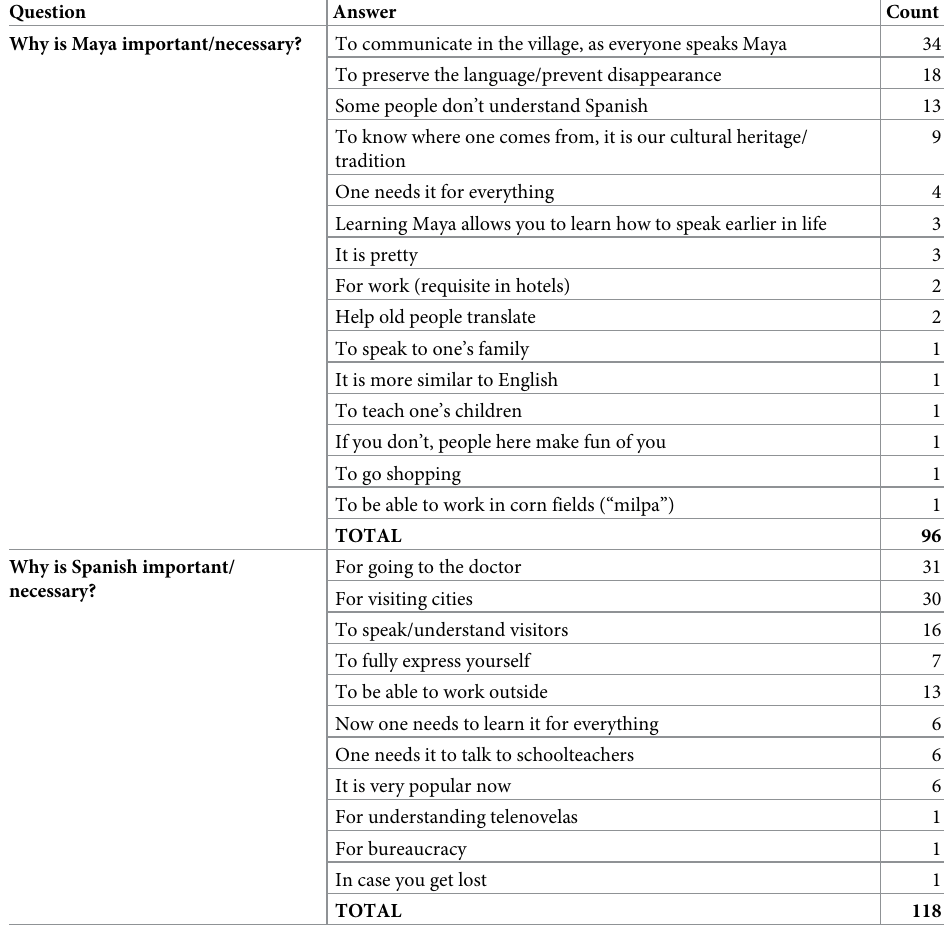
Table 1. Answers to questions regarding why each language is important from